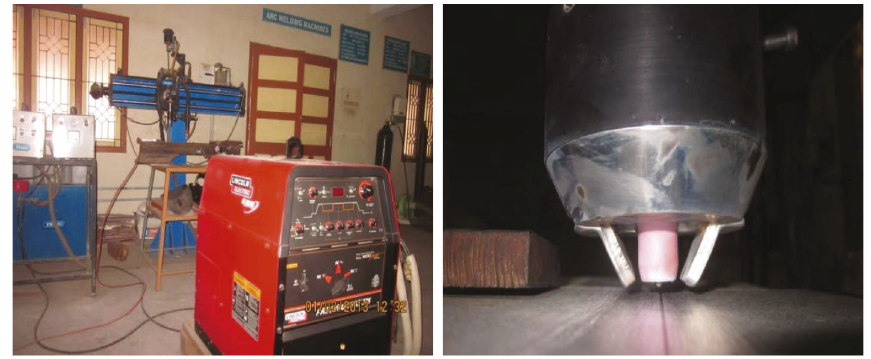
Figure 1: Photographs of MAO unit.